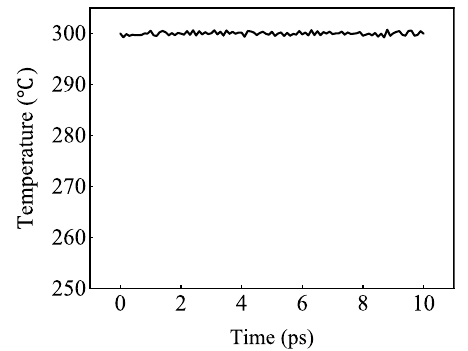
Figure 2. The MSD curve of relaxation temperature.